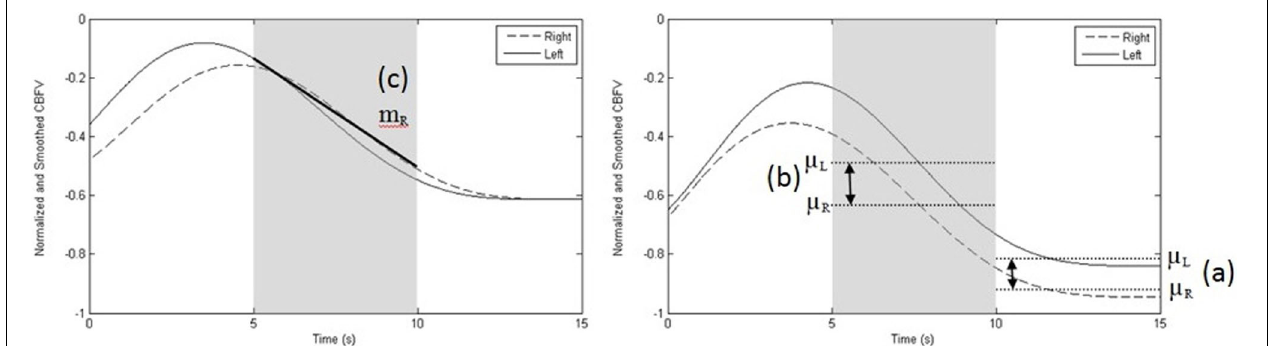
FIGURE 5 | Sample recording depicting the three most common features. (a) difference between left and right mean velocities, μ L– μ R, at 10–15s (right graph); (b) difference between left and right mean velocities, μ L– μ R, at 5–10s (right graph), and, (c) slope of the right MCA CBFV (mR) at